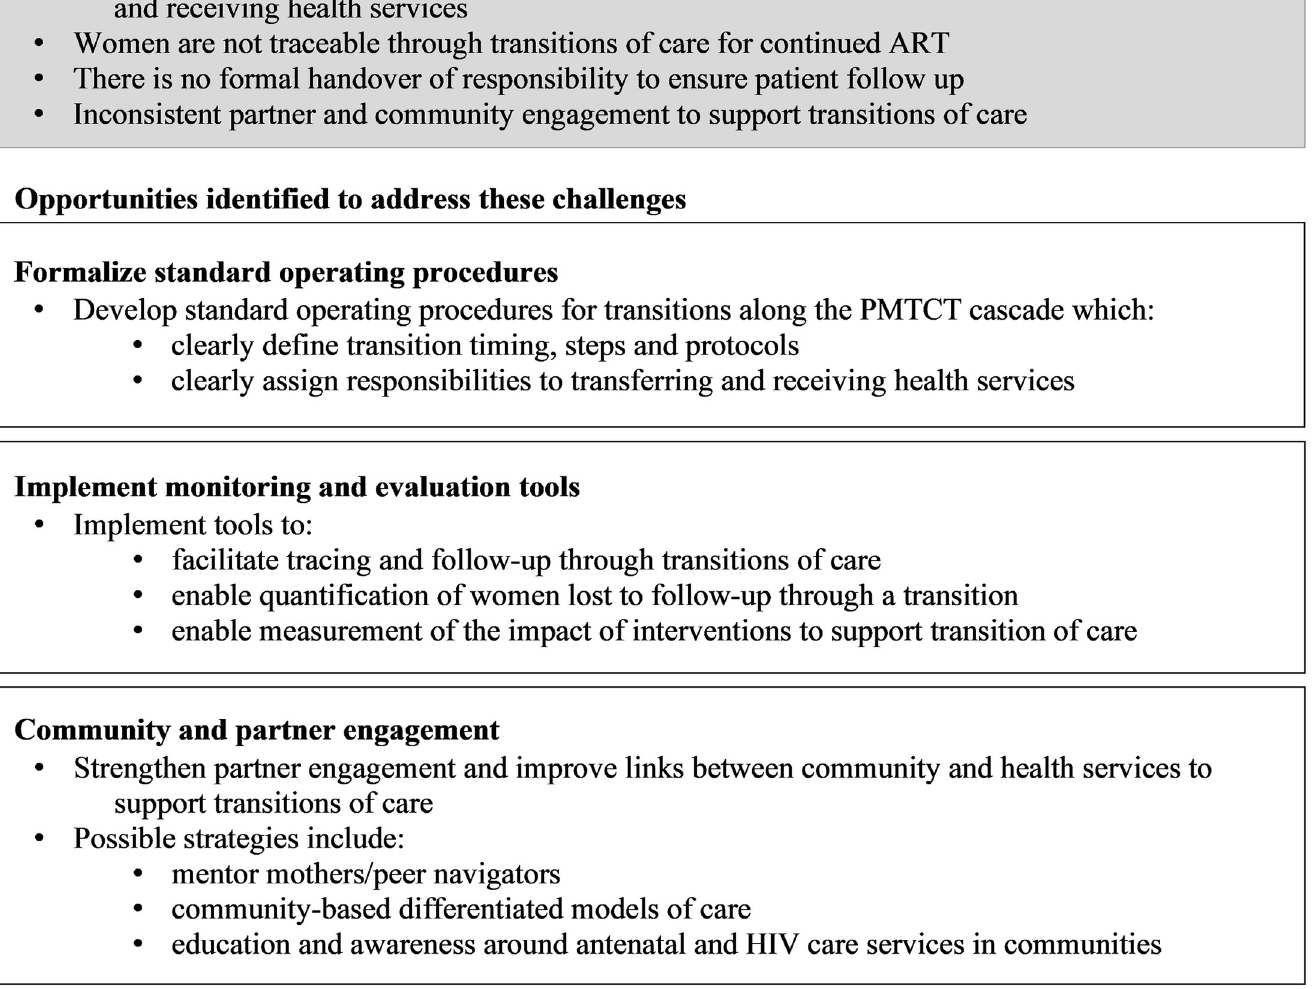
Fig 2. Summary of the challenges and opportunities identified in key informant interviews to strengthen transition of care for continued ART along the PMTCT cascade.